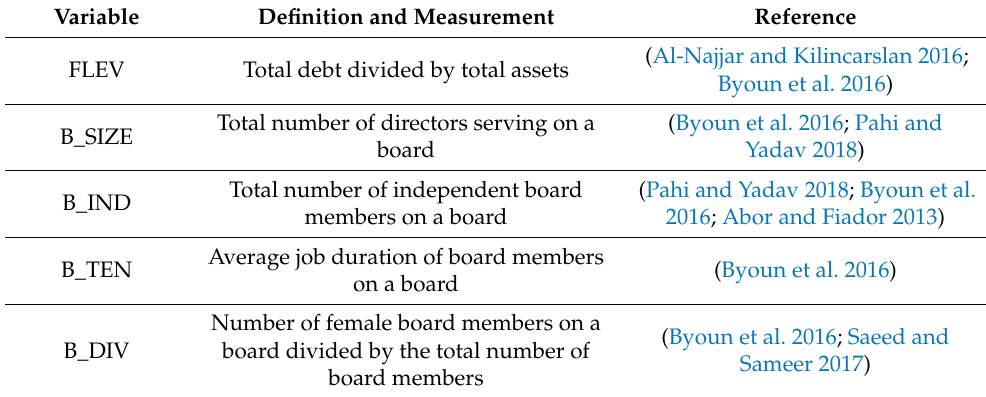
Table 1. Variable definitions and measurements.